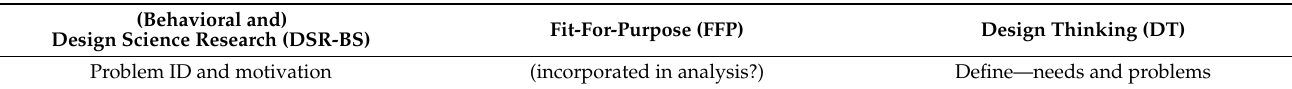
Table 5. Extract of problem identification